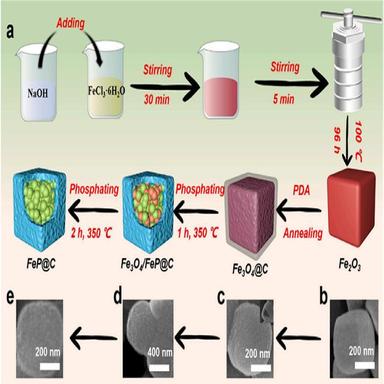
Diagram depicting the synthesis process for the Fe3O4/FeP@C, Fe3O4@C and FeP@C.